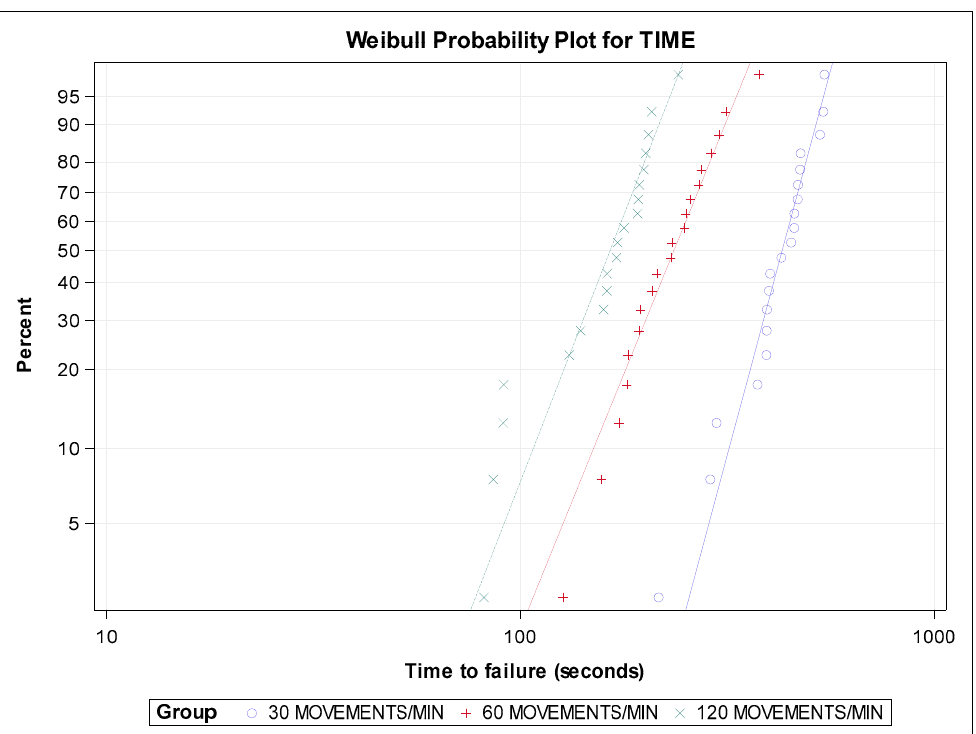
Figure 5. Weibull probability plot of the time to failure.